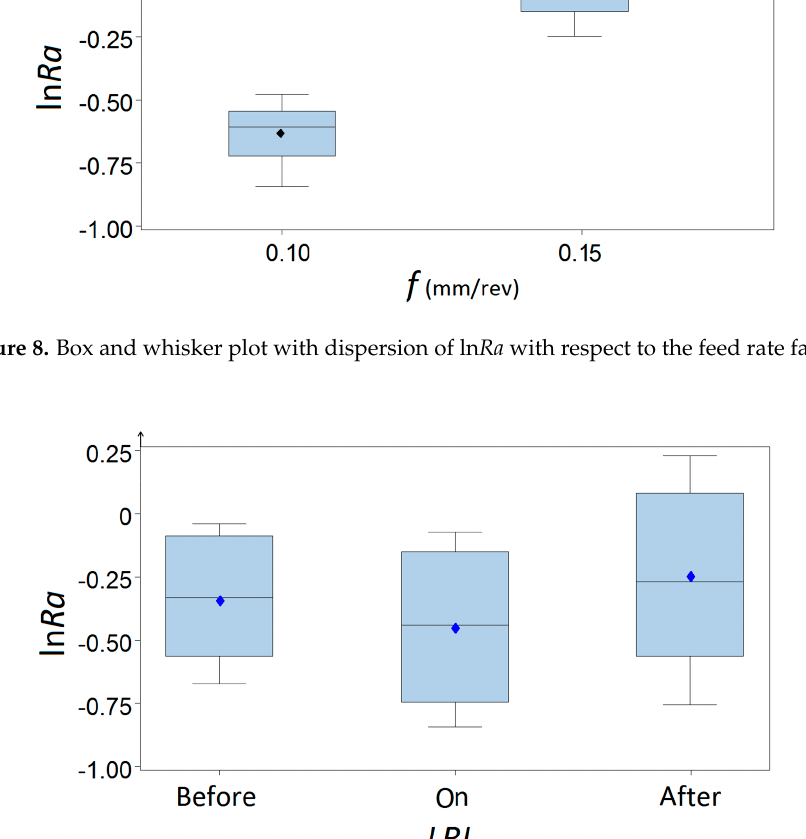
Figure 9. Box and whisker plot with the dispersion of ln Ra versus location with respect to the insert factor.